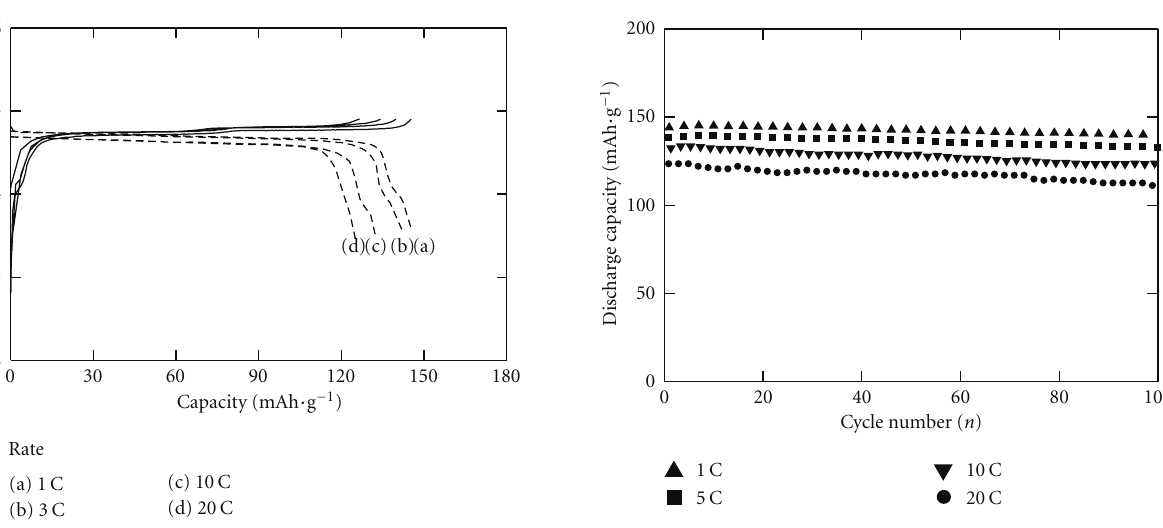
Figure 5: Discharge curves of LiNi 0 . 5 Mn 1 . 5 O 4 cathode at rate indicated.